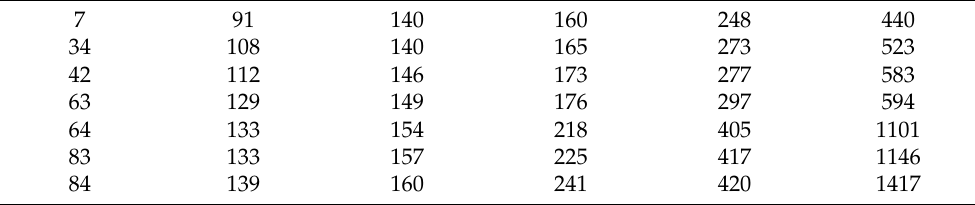
Table 1. Lifetimes of individuals who were diagnosed with Head and Neck